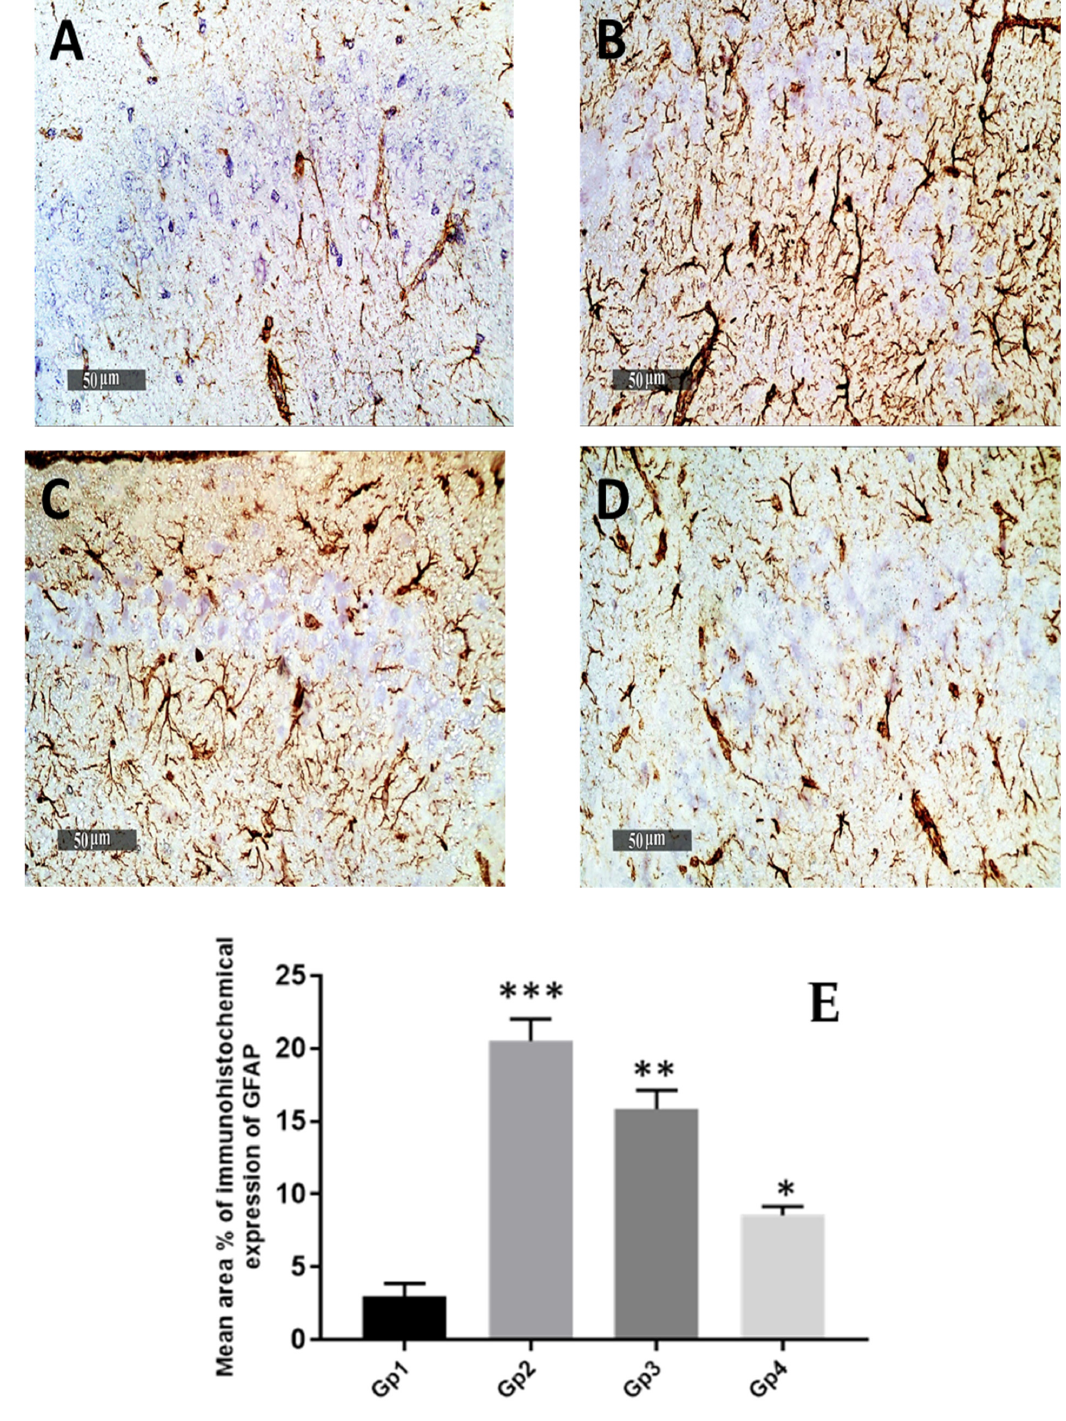
Figure 9. Effect of different treatments on hippocampal GFAP immuno-histochemical levels in reactive astrocytes expressed as the mean area percentage of expression. ( A ) Normal group, ( B ) Negative control group, ( C ) Positive control group and ( D ) Test group. 400 × . The bar chart ( E ) shows the mean ± SD of the % area of immuno-histochemical levels expression of GFAP, where Gp 1 represents the normal group, Gp 2, Gp 3 and Gp 4 represent the negative control group (received 0.9% saline), positive control group (received resveratrol suspension) and test group (received resveratrol bilosomes), respectively, where (*), (**) and (***) indicate statistically significantly different values from the control group at ( p < 0.05, p < 0.01 and p < 0.001),